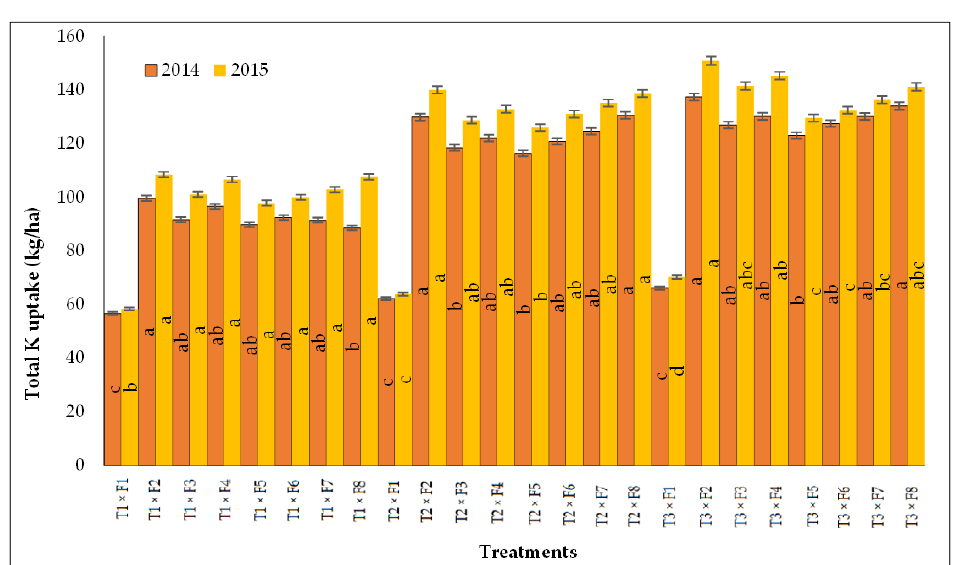
Figure 3. The combined effect of crop establishment methods and integrated nutrient management influence the total K uptake by rice in both years. Treatments details are in Table 1; Within each treatment combination, bars followed by the same lower-case letter(s) indicate significant differences at 5% level of probability. SE ± in each treatment combination was calculated from three